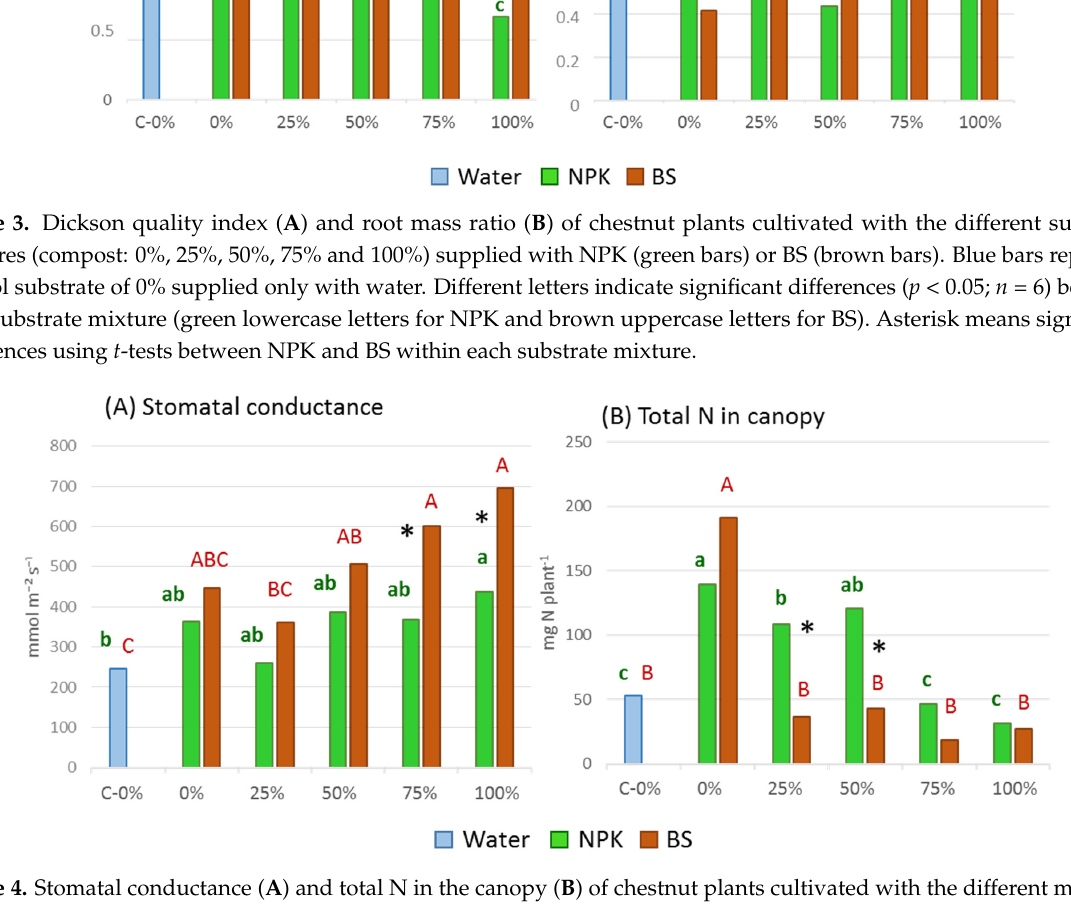
Figure 4. Stomatal conductance ( A ) and total N in the canopy ( B ) of chestnut plants cultivated with the different mixtures (compost: 0%, 25%, 50%, 75% and 100%) supplied with NPK (green bars) or BS (brown bars). Blue bars represent control substrate 0% supplied only with water. Different letters indicate significant differences ( p < 0.05; n = 6) between each substrate mixture (green lowercase letters for NPK and brown uppercase letters for BS). Asterisk means significant differences using t-tests between NPK and BS within each substrate mixture.